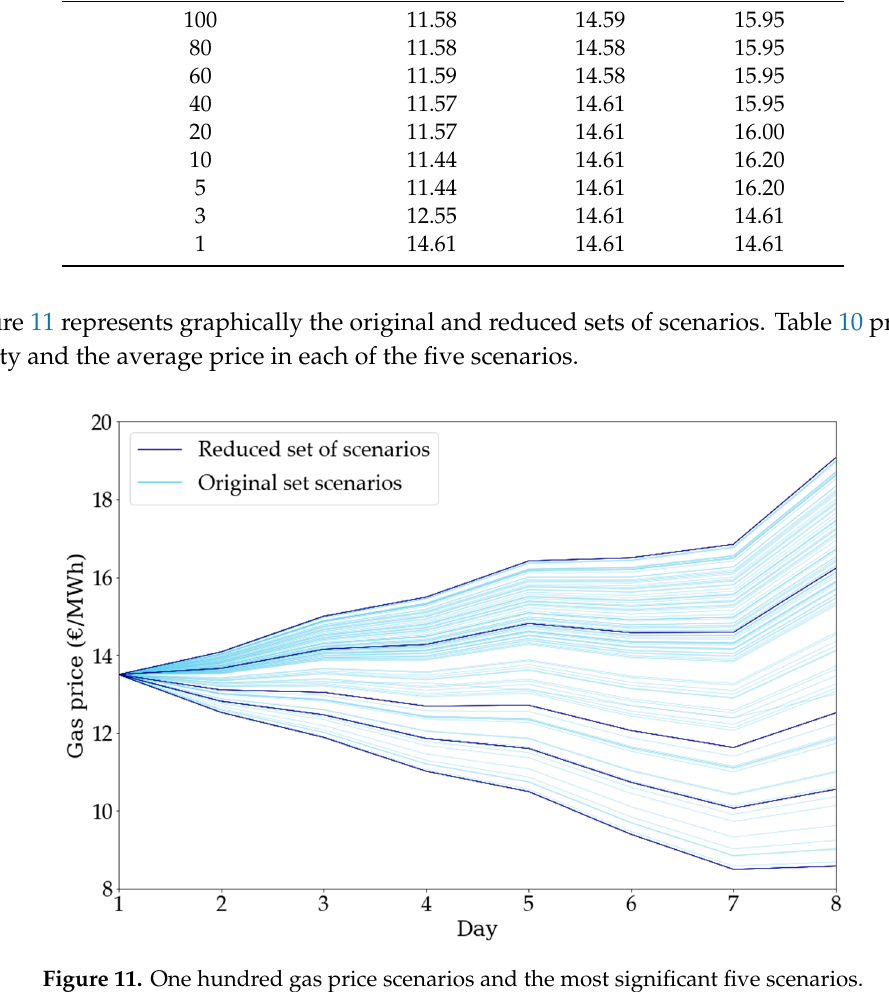
Figure 11. One hundred gas price scenarios and the most significant five scenarios. Table 10. Probabilities of the most significant five gas price scenarios.